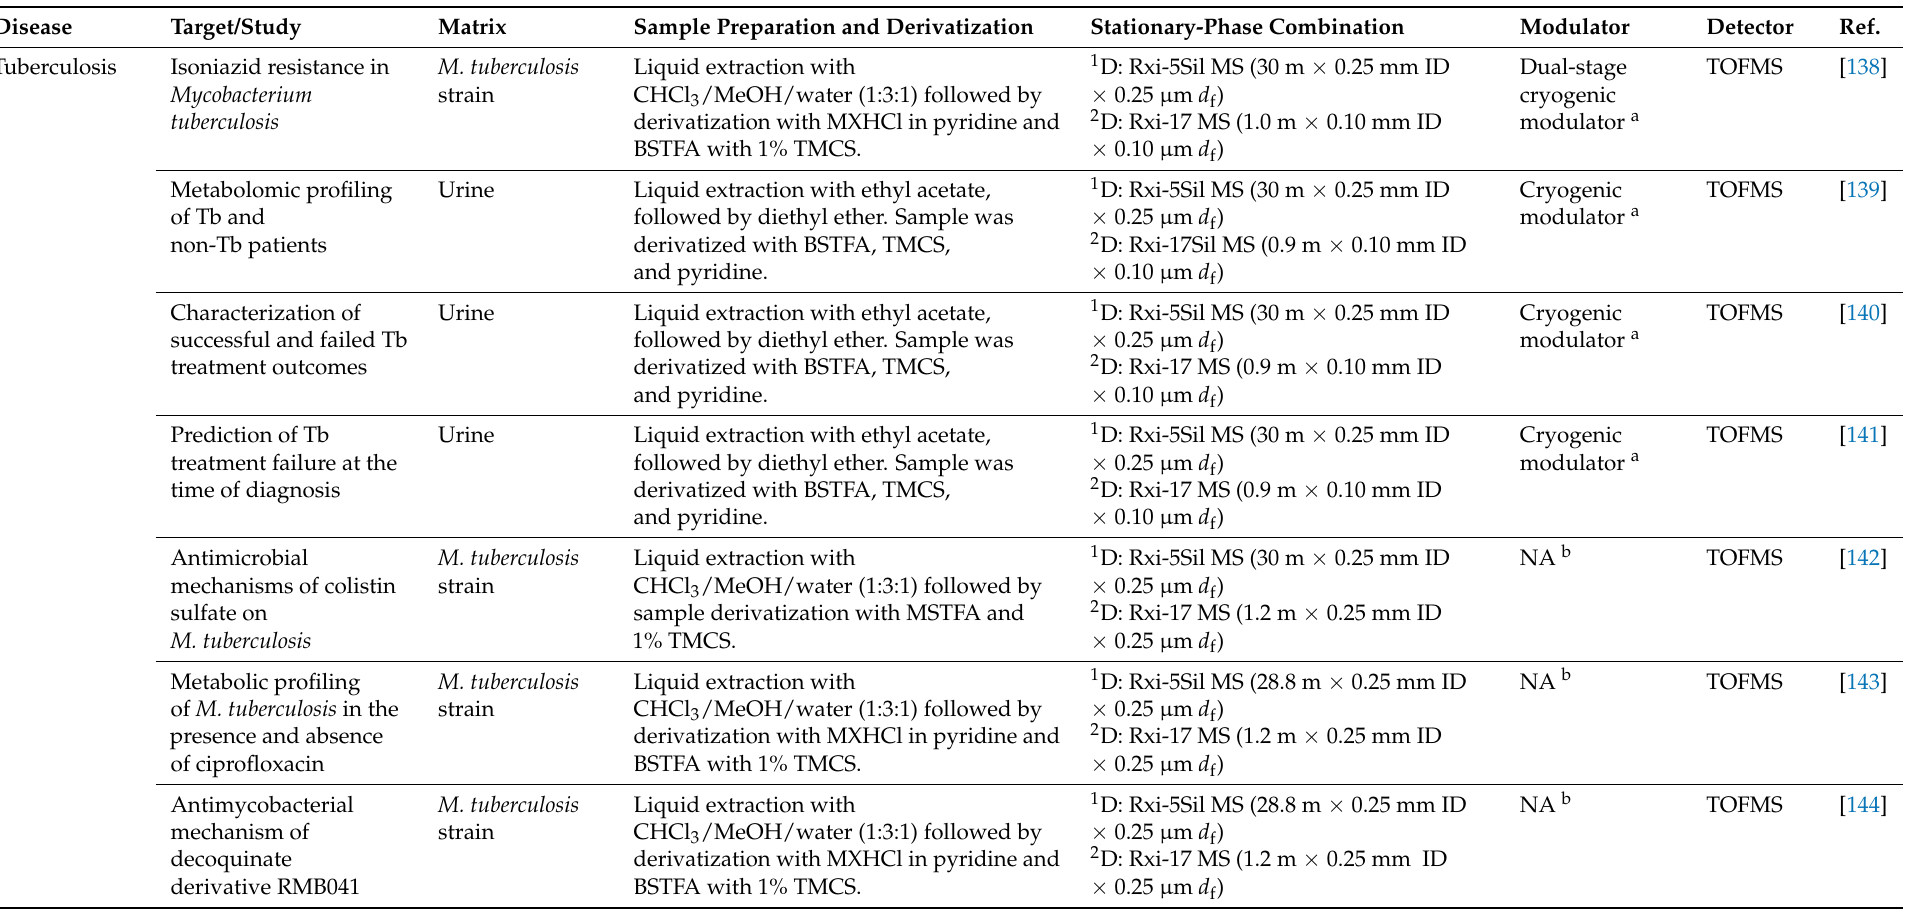
Table 1. Summary of GC × GC strategies in the field of drug discovery and analysis. Disease Sample Preparation and Derivatization Stationary-Phase Combination Modulator Detector Ref. Liquid extraction with CHCl 3 /MeOH/water (1:3:1) followed by derivatization with MXHCl in pyridine and BSTFA with 1% TMCS. Liquid extraction with ethyl acetate, followed by diethyl ether. Sample was derivatized with BSTFA, TMCS, and pyridine. Liquid extraction with CHCl 3 /MeOH/water (1:3:1) followed by sample derivatization with MSTFA and